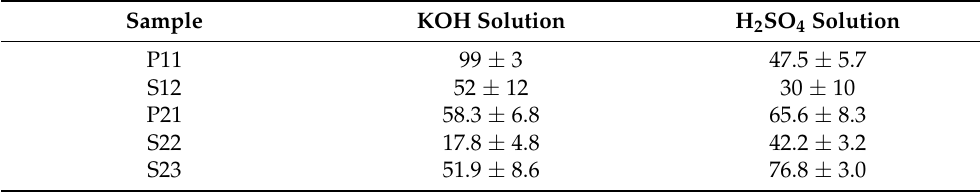
Table 7. Capacitive current contribution in an alkaline solution averaged in the potential window from − 0.759 to − 0.559 V, and in acidic solution averaged between 0.241 and 0.491 V vs. SHE. The evaluation is completed for the sweep rate of 20 mV s − 1 and given in